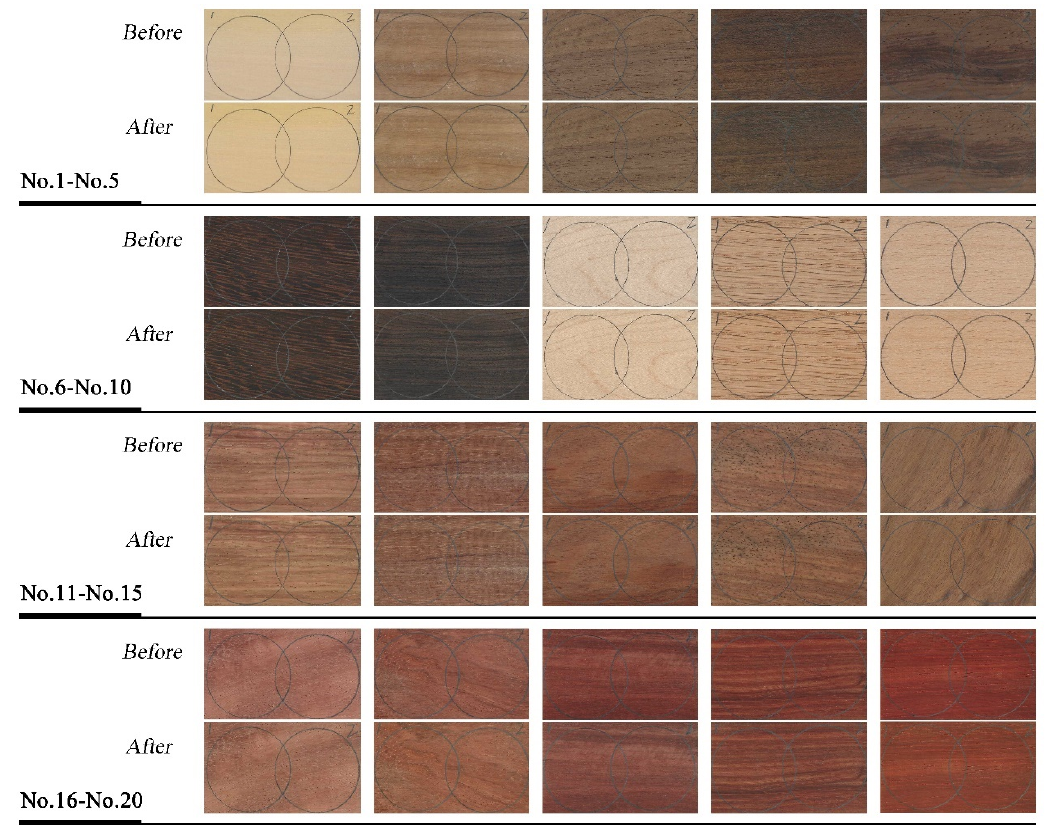
Figure 6. Comparison of the scanned wood grain images before and after the chromatic aberration correction.